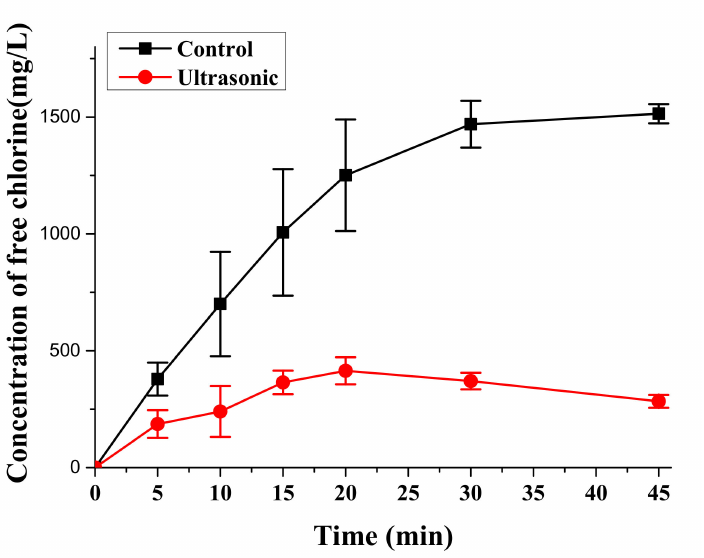
Figure 5. Variations in the concentration of free chlorine during digestion operation (45 min). As shown in Figure 7, the micromorphology of undissolved solid matters before and after UAEO digestion was observed using FE-SEM and OM. The undissolved solid matters before digestion (Figure 7A,B) presented typical micromorphological characteristics of the dairy slurry, an irregular blocky structure. As shown in Figure 7D,E, the blocky structure appeared as arc edge and cellular structure after the UAEO digestion method. More macroscopic OM images (Figure 7C–E) showed that the digestion process not only reduced the amount of undissolved solid matters but also made them fragmented and